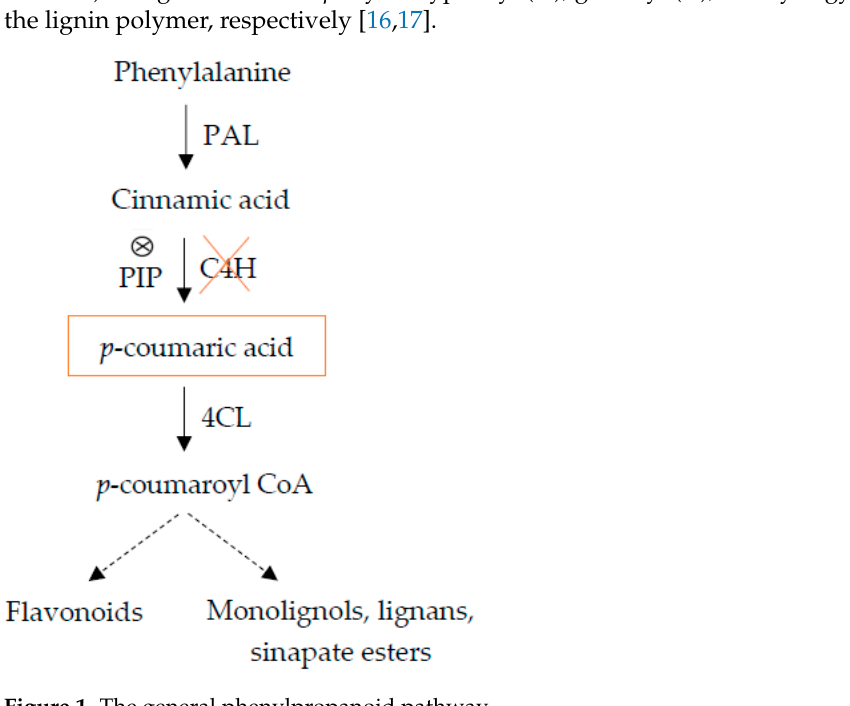
Figure 1. The general phenylpropanoid pathway.